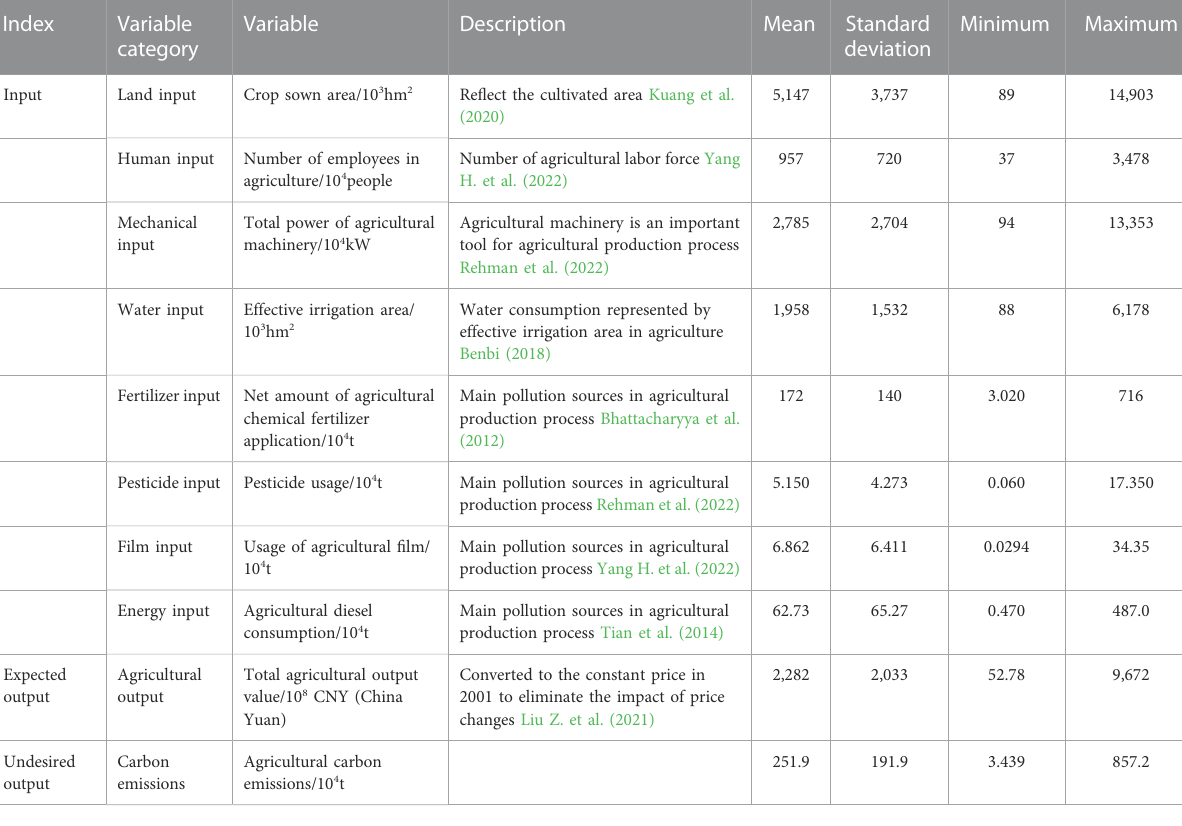
TABLE 1 Variable de fi nitions and descriptive